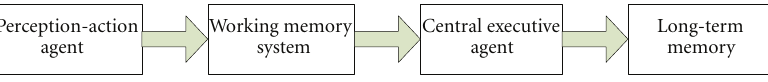
Figure 7: Work loop of the learning